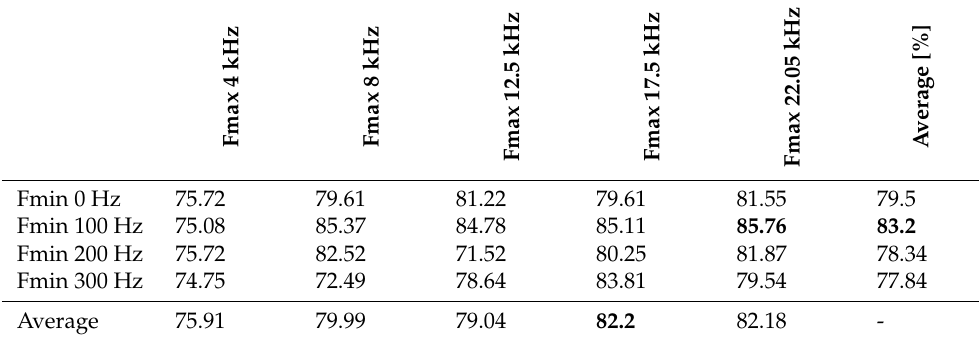
Table 2. Accuracies for different lower- and upper-frequency limits. The averaged values for both limits are also given. The best options are in bold.